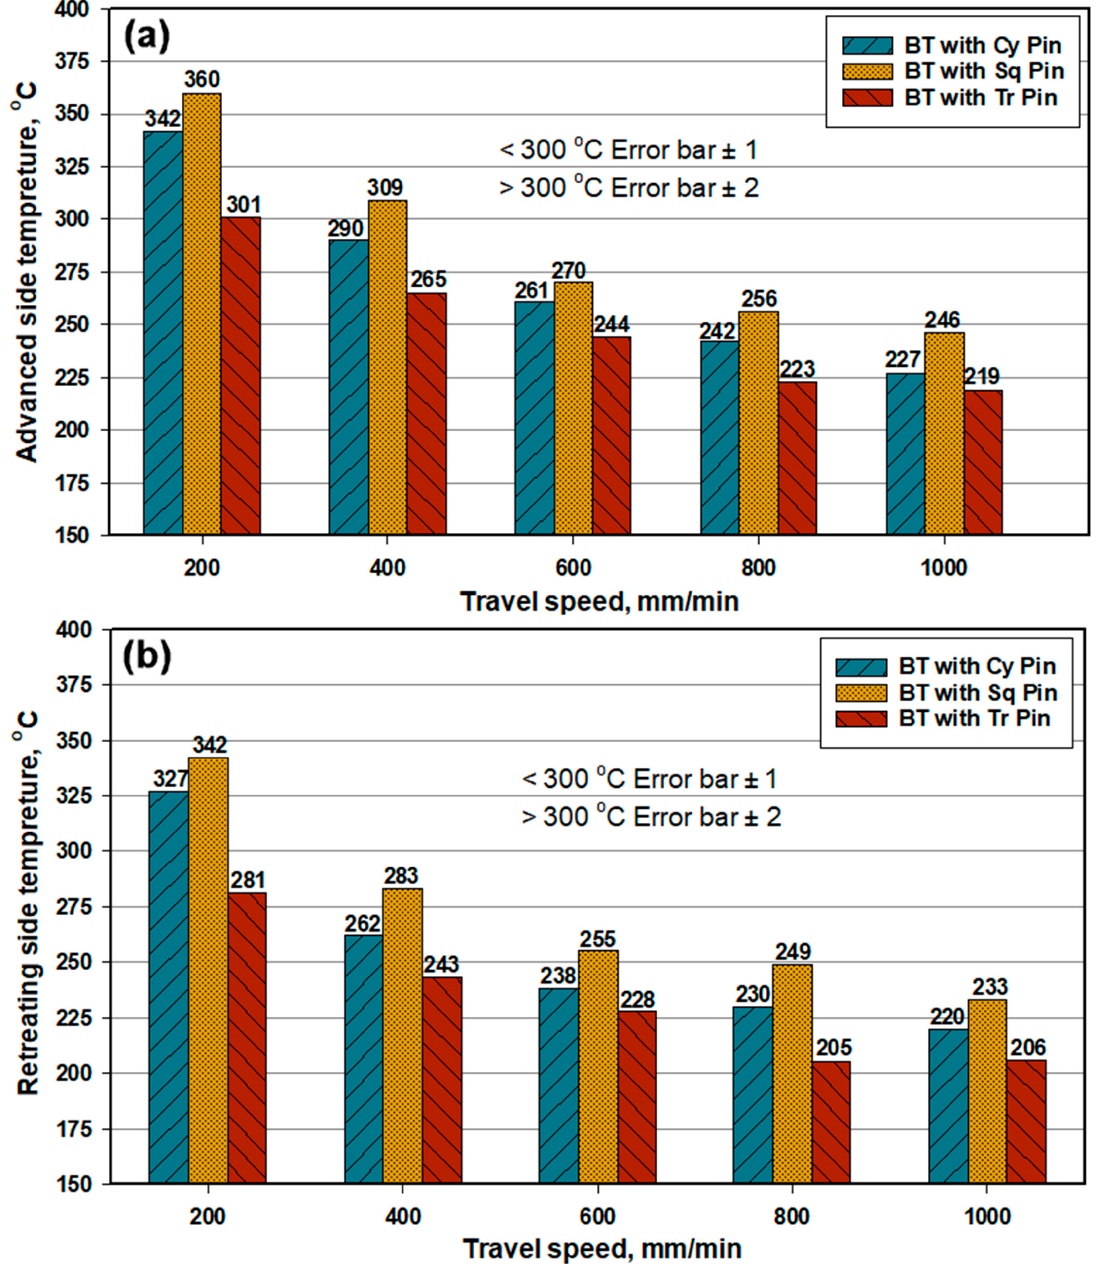
Figure 8. Maximum temperature measured at ( a ) the advancing side and ( b ) the retreating side with different pin profiles.